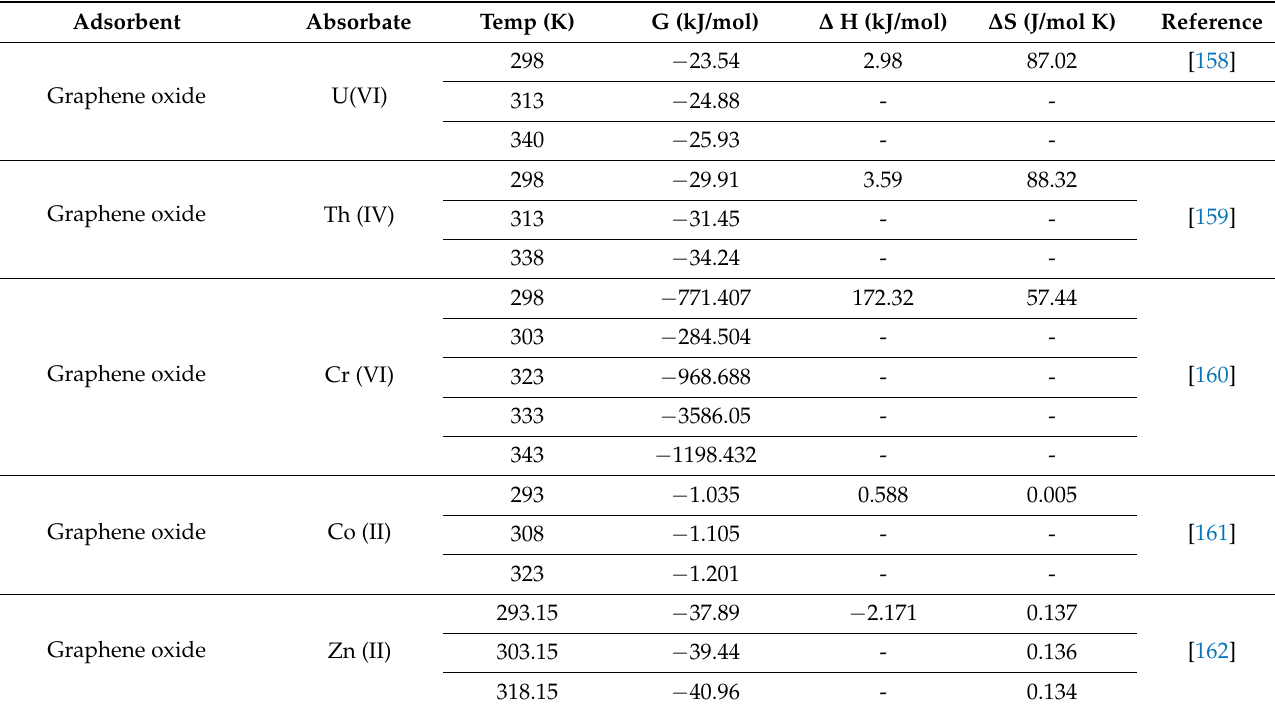
Table 4. Thermodynamic parameters from the literature with adsorption of heavy metals and dyes using graphene oxide–metal